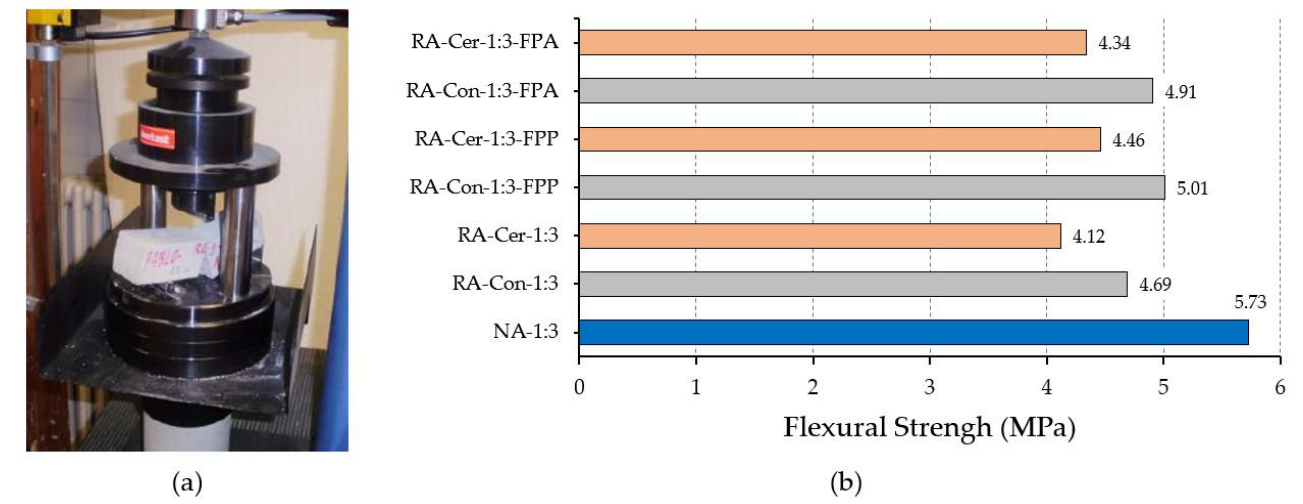
Figure 3. ( a ) Flexural strength test; ( b ) results of the flexural strength test.